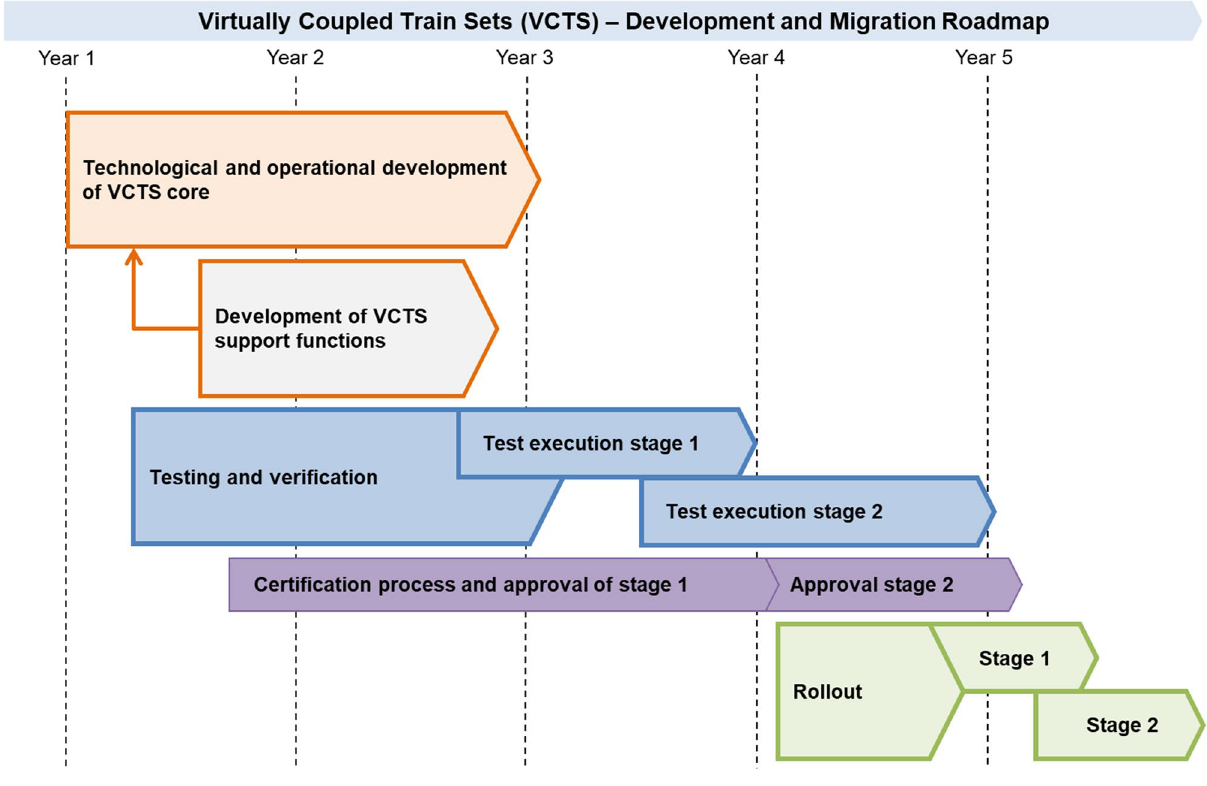
Figure 7. Qualitative roadmap for VCTS